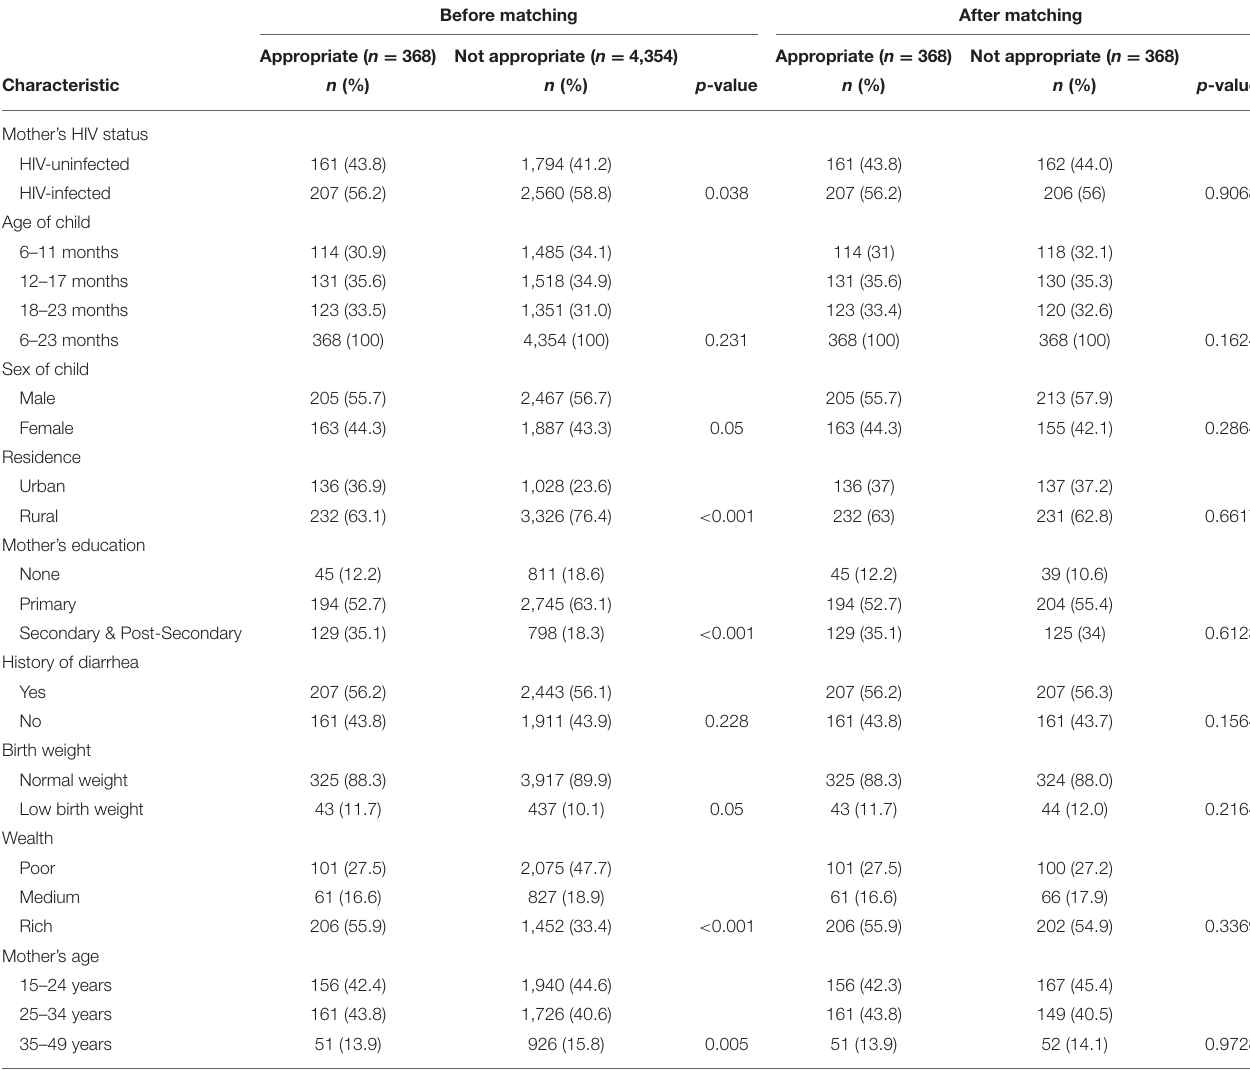
TABLE 4 | Distribution of characteristics between appropriately and inappropriately fed children before and after matching. Before matching After matching Appropriate ( n = 368) Not appropriate ( n = 4,354) Appropriate ( n = 368) Not appropriate ( n =